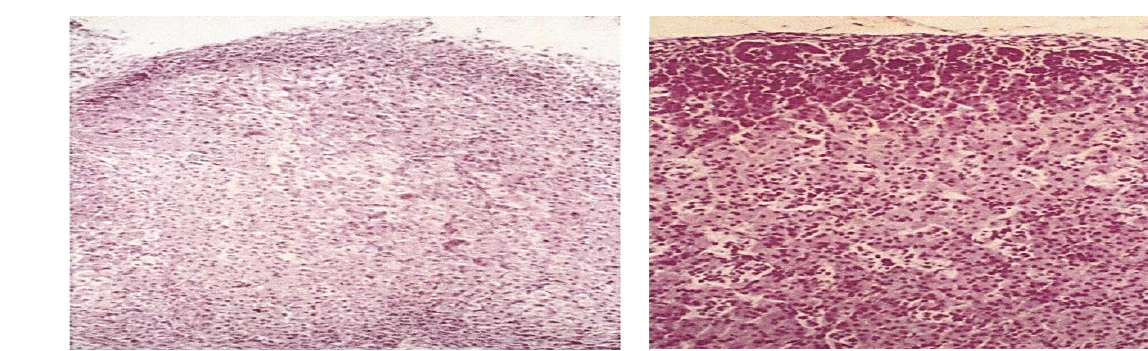
Figure, 2: Adrenal cortex of fetal goat, CRL= 25cm,100day : Zona glomerlosa cells are small and stain darker . There is clear line of demarcation between zona glomerlosa and fasciculate ( M. H.